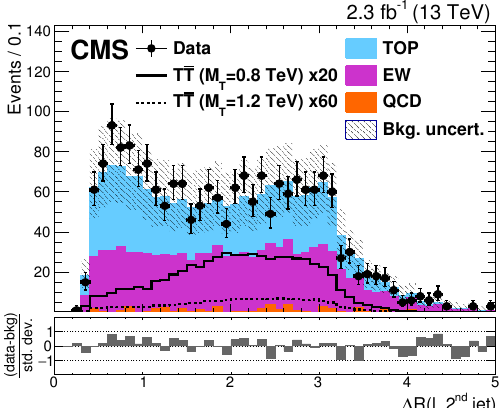
Figure 5 . Distribution of (cid:1) R ( ‘; j 2 ) in the boosted W channel after all selection requirements except for (cid:1) R ( ‘; j 2 ) > 1. Also shown are the distributions of TT signal events with T quark masses of 0.8 and 1.2 TeV, scaled by factors of 20 and 60, respectively. The uncertainty in the background includes the statistical and systematic uncertainties described in section